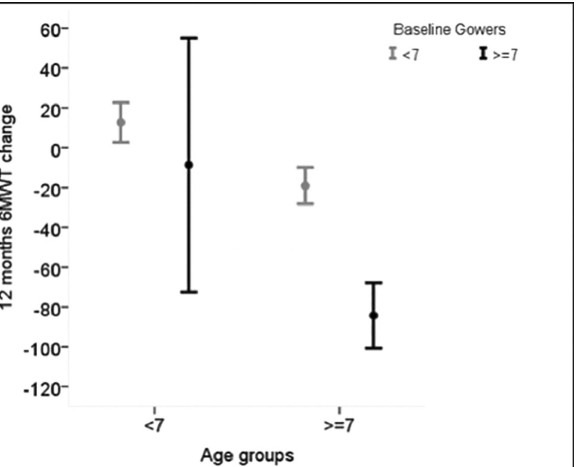
Fig 4. Average 6MWD change over 12 months according to baseline age ( < 7 years vs > = 7 years) in those with baseline TRF < 7 sec and in those with baseline TRF > = 7 sec. The borderline significant age by TRF interaction (p = 0.06) indicates that the baseline value of TRF has an impact on the 6MWD change only in children older than 7